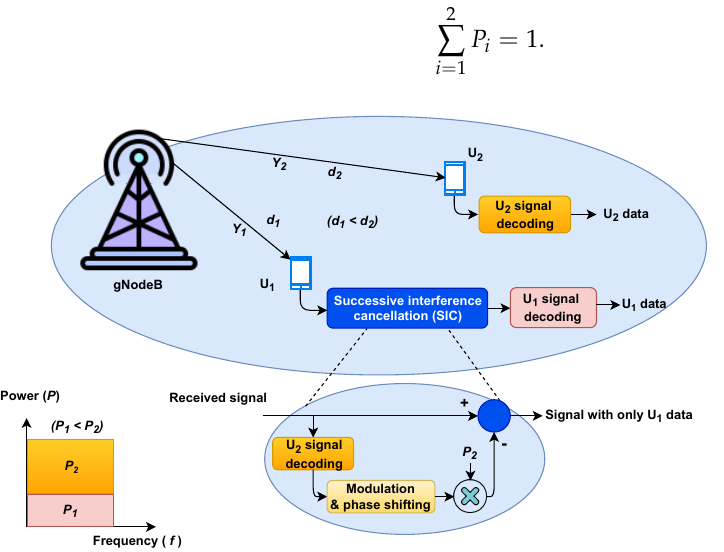
Figure 1. SISO downlink PD-NOMA system (U 1 is near-user and U 2 is far-user). Each user’s signal is modulated with Binary Phase Shift Keying (BPSK) along distinct phase offsets and assigned with corresponding power factors via FIS at the gNodeB, and is given by: